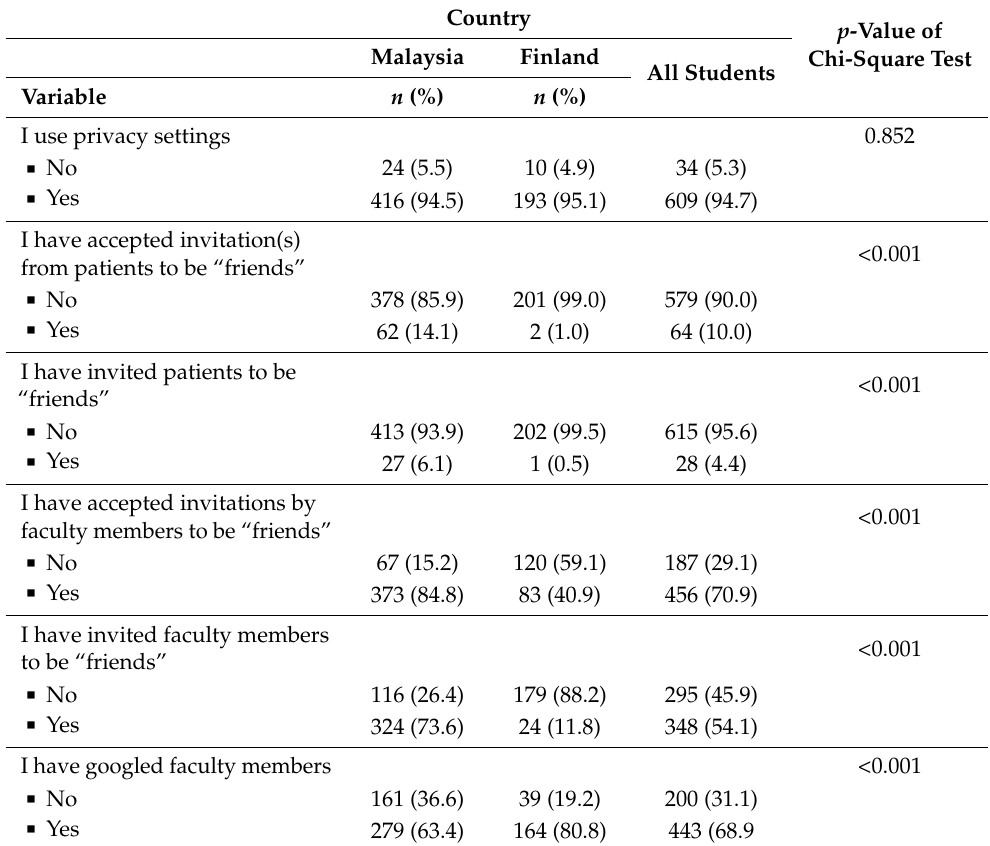
Table 4. Frequency and percentage distributions of responses to the question “What concerns do you have about social media use?” by country. Data include dental undergraduate students from Malaysia ( n = 440) and Finland ( n =